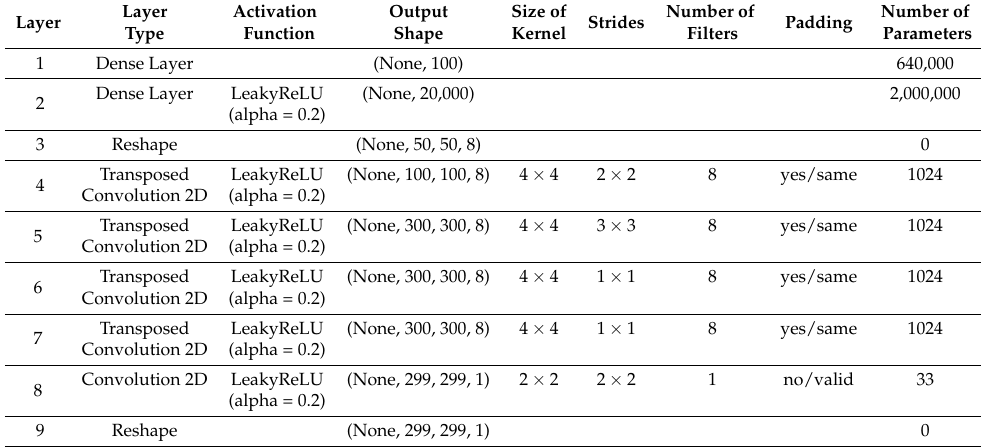
Figure 4. Dimensions of different layers of the GDN part of the proposed GDN-GAN. Table 2. Details of the generator part of the proposed GDN-GAN